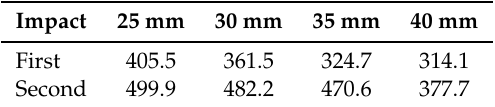
Table 6. Peak accelerations measured for each impact